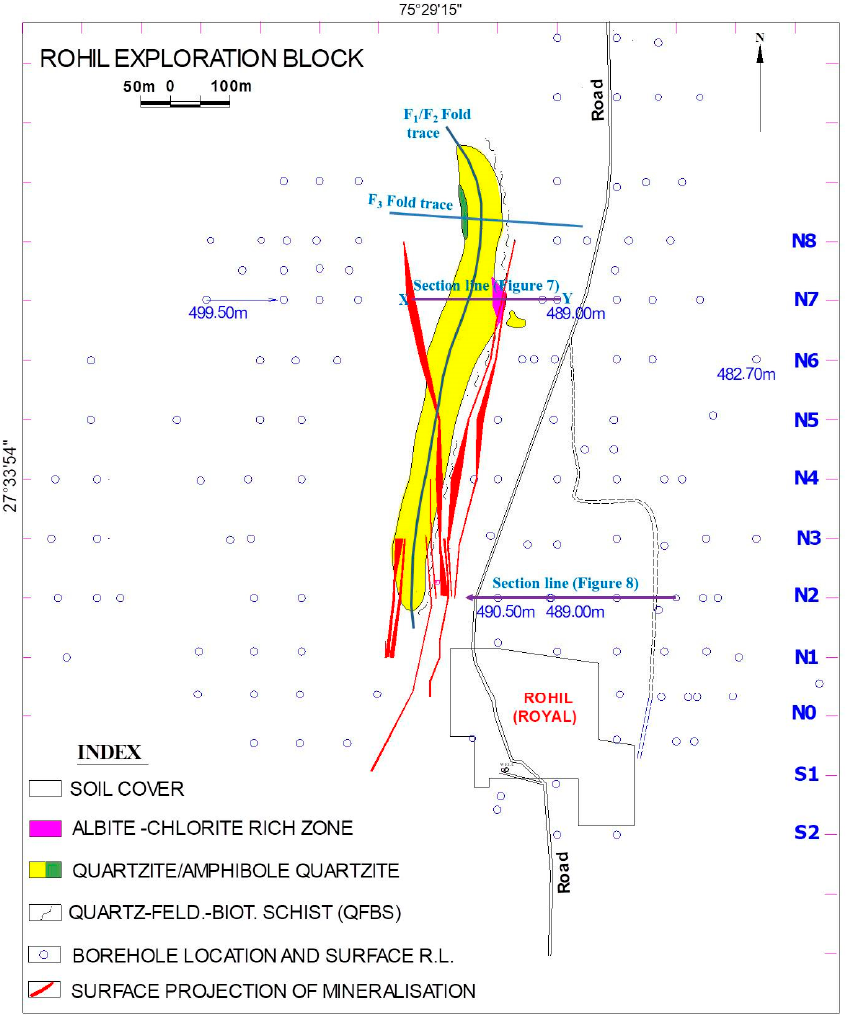
Figure 3. Rohil exploration block showing borehole locations and the projection of ore